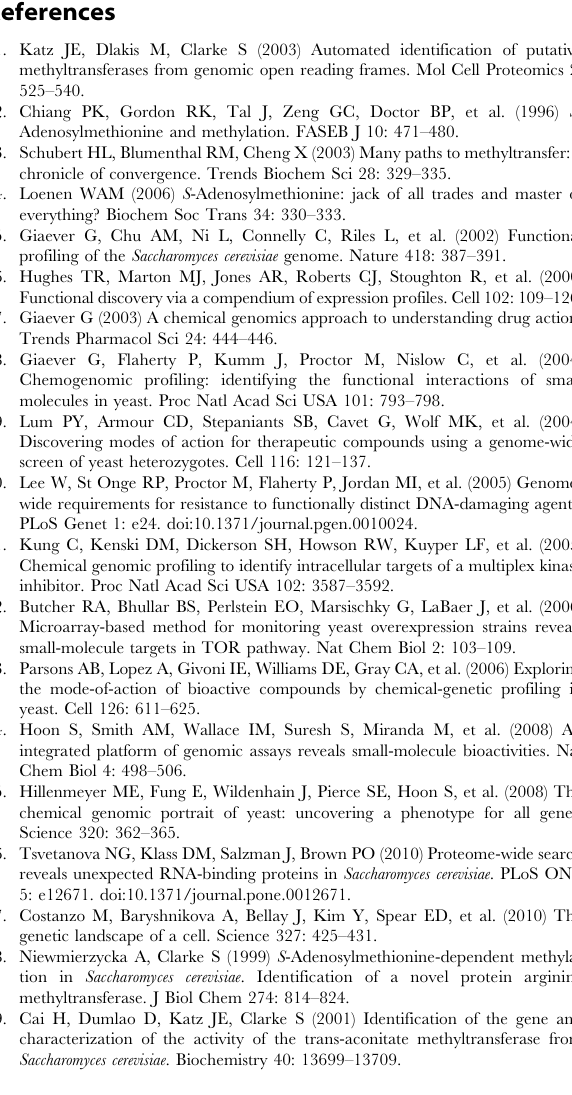
onto solid YPD medium containing fenpropimorph (250 m M), and incubated at 30 u C for 2–3 days. Table S1 Significantly enriched ( P -value , 1.0 6 10 2 6 ) Gene Ontology Biological processes for significantly up- and downreg- ulated genes (log2 . 1 and ,2 1) in the presence of cantharidin. Table S2 Differentially expressed genes of methionine biosyn- thesis in crg1 mutants under cantharidin stress. Table S3 Cantharidin-specific genetic interactors of CRG1 . (XLSX) Table S4 Statistical analysis (Kruskal-Wallis test) of lipid abundance in crg1 mutants exposed to cantharidin. Table S5 Yeast strains used in this study. Table S6 Plasmids used in this study.